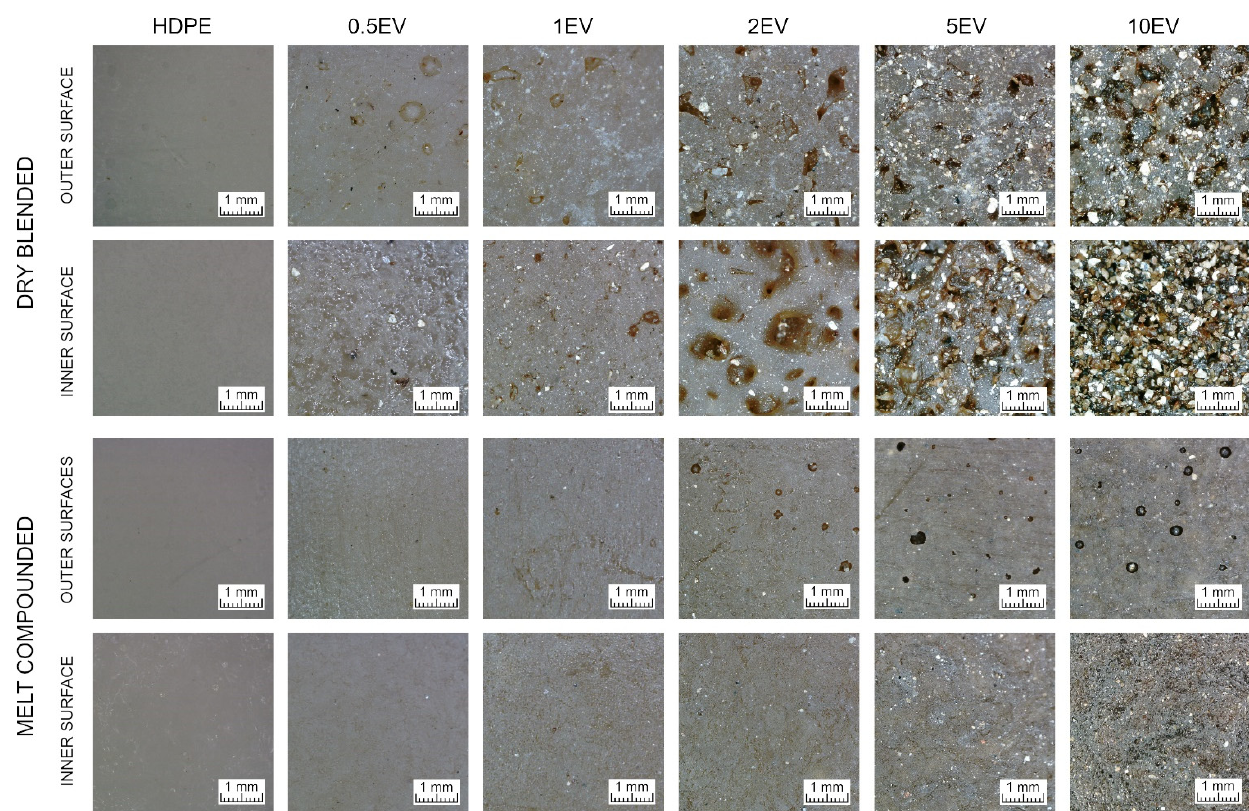
Figure 4. Optical microscope photographs of outer and inner surfaces of rotomolded samples.